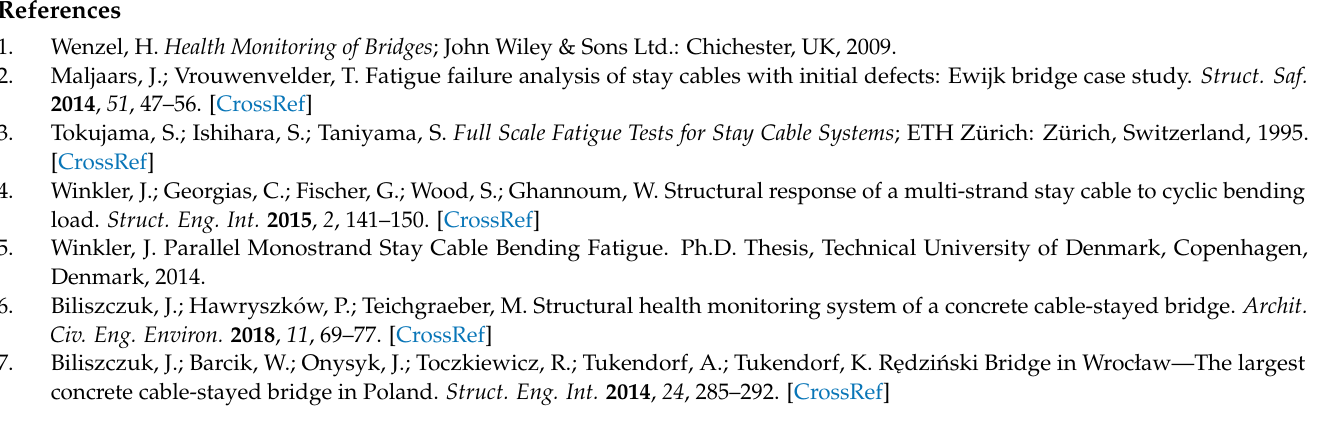
Figure 23. Accelerometers used for determination of a stay cable force.